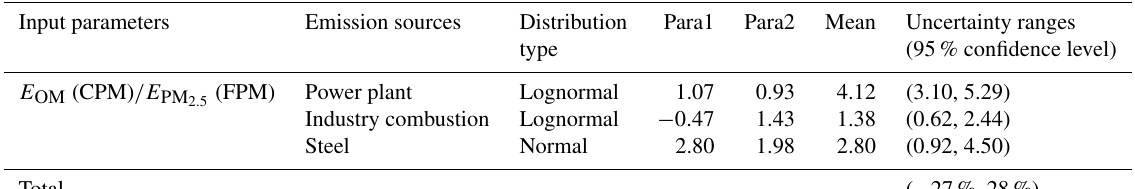
Figure 1. (a) Map of the modeling domain and the location of each target city in the model evaluation. (b) The locations of the BTH2 + 26 cities are denoted using the red frame in panel (a) . The colored shading represents the regional altitude. (FPM) ratio (95% confidence interval). “Para1” Table 3. Probabilistic distributions with uncertainty ranges in the E OM (CPM) /E PM 2 . 5 represents the mean for normal distributions and the mean of ln( x ) for lognormal distributions. “Para2” represents the standard deviation for normal distributions and the standard deviation of ln( x ) for lognormal distributions. “Mean” represents the mean for emission ratios of each source category derived from the statistical bootstrap